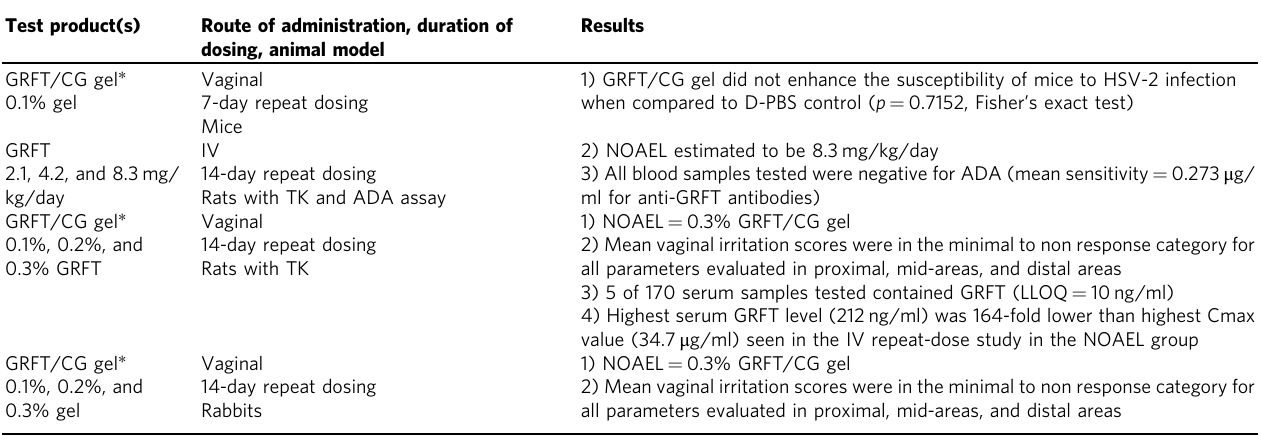
Table 3 Safety studies of GRFT and GRFT/CG Test